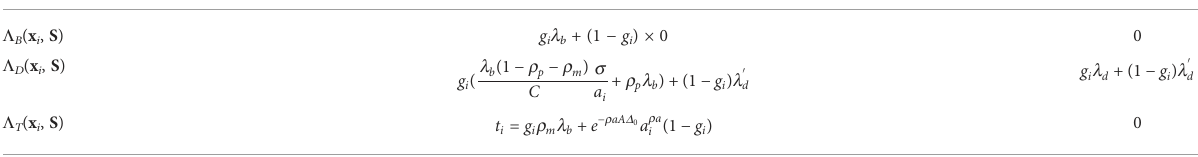
TABLE 2 Birth, death, and transformation